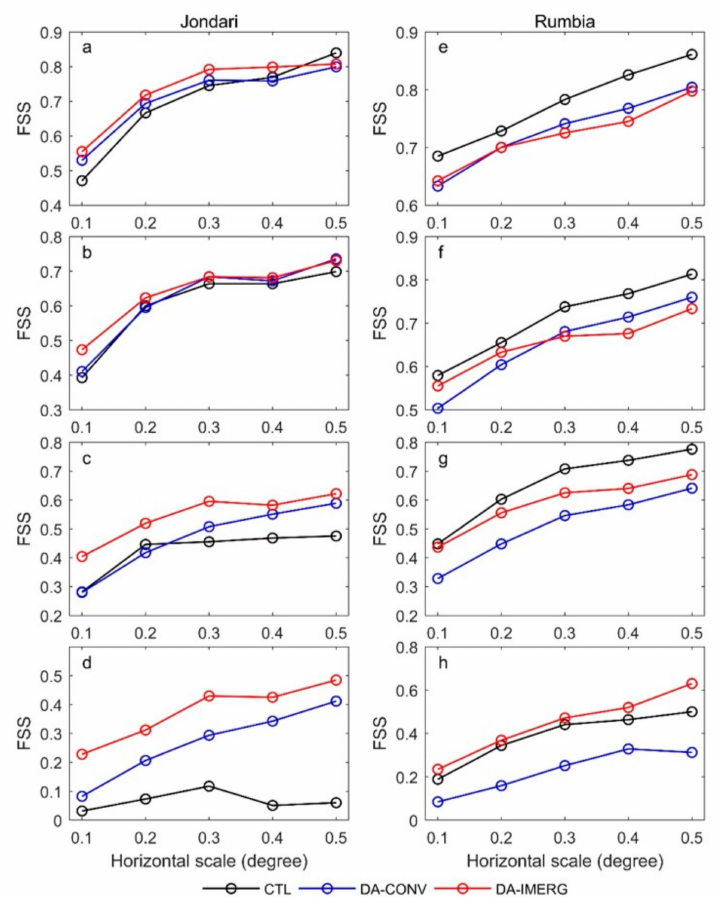
Figure 13. The aggregated fractions skill scores for hourly precipitation threshold of ( a , e ) 1.0 mm / h, ( b , f ) 2.5 mm / h, ( c , g ) 5.0 mm / h, and ( d , h ) 10 mm / h at di ff erent horizontal